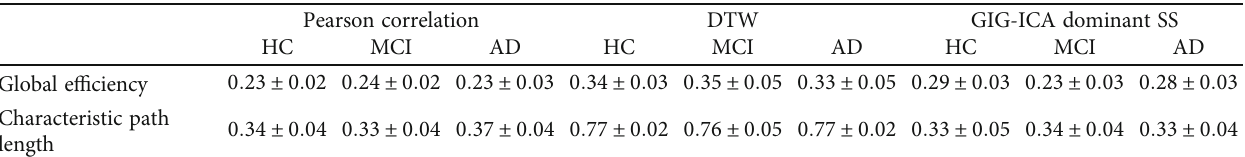
Table 3: Network-level topological metrics ( mean ± standard ) derived from rs-FC networks, including global e ffi ciency and characteristic path